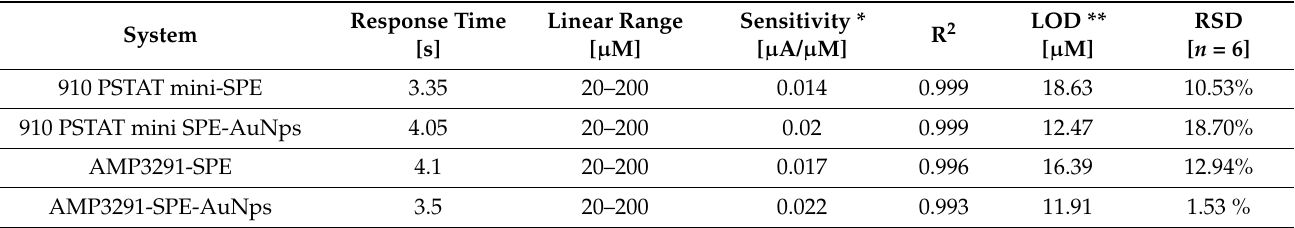
Figure 6. Comparison of the sensing platform in PBS with AMP3291 and 910 PSTAT mini using ( a ) SPE, ( b )SPE-AuNps and ( c ) differences in registered amperometric current for SPE and SPE-AuNps in the AMP3291 reader. Table 1. Analytical figures of merit for AMP3291 and 910 PSTAT mini